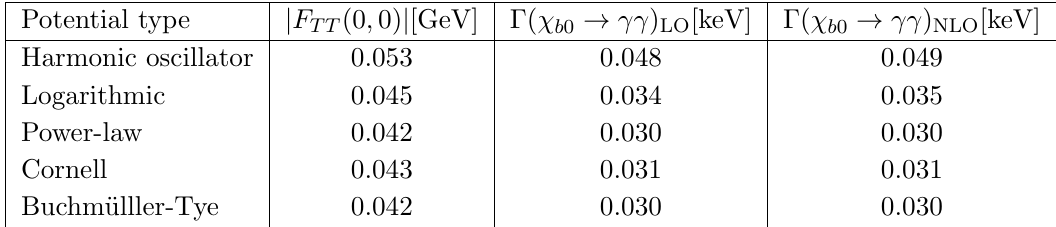
Table 5 . j F TT (0 ; 0) j for (cid:31) b 0 with quark/antiquark m b = 4.18 GeV according to PDG